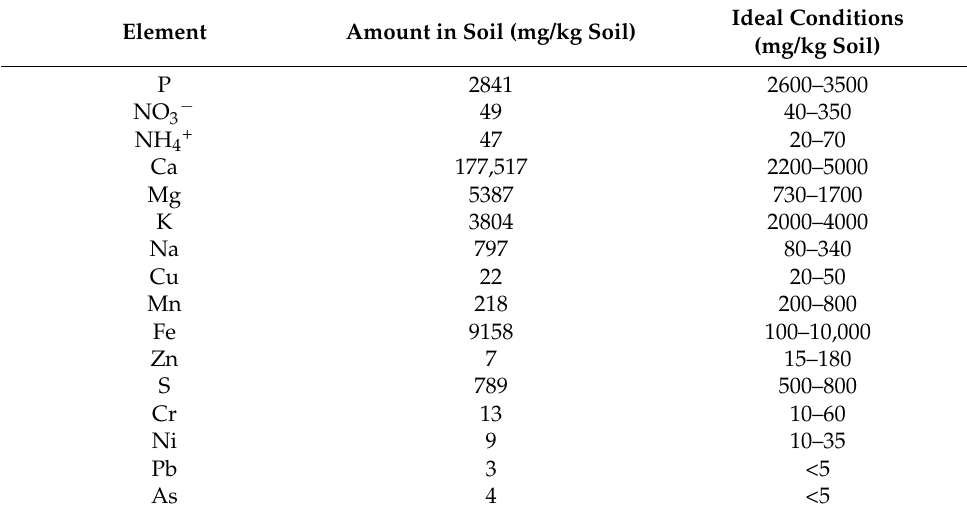
Table 1. Chemical composition of the studied